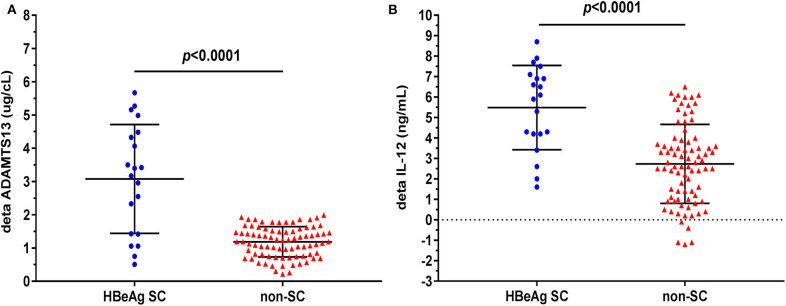
Difference of plasma delta (Δ) ADAMTS13 or delta (Δ) IL-12 levels between CHB patients with HBeAg seroconversion (SC) and without. ΔADAMTS13 (change after m-ETV treatment of 48 weeks) (A) levels are significantly higher in CHB patients with HBeAg SC than in those without SC; similarly, plasma ΔIL-12 (B) levels are significantly higher in patients with HBeAg SC. Data are expressed as scatter plots, in which the middle of the black solid line is the median, and the up and down horizontal lines represent the 25th and 75th percentiles, respectively.